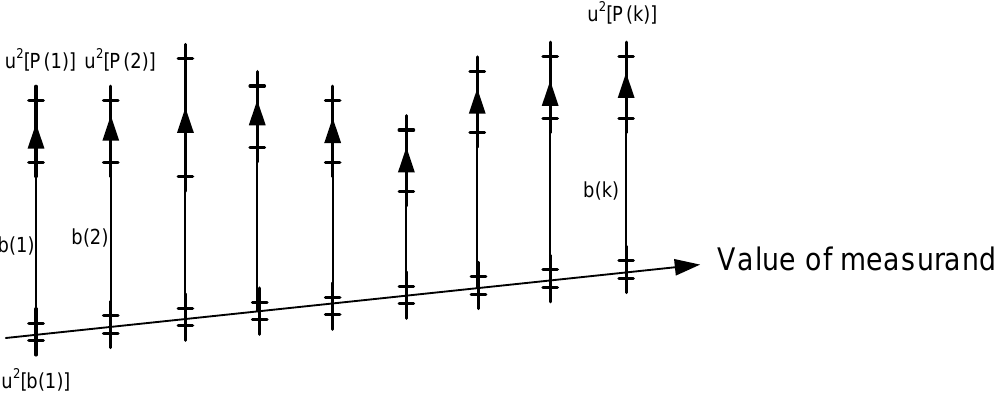
Figure 8. Graphical example for the calculation of uncertainty showing unknown value at the bottom, a systematic difference at each position, the uncertainty in determining as